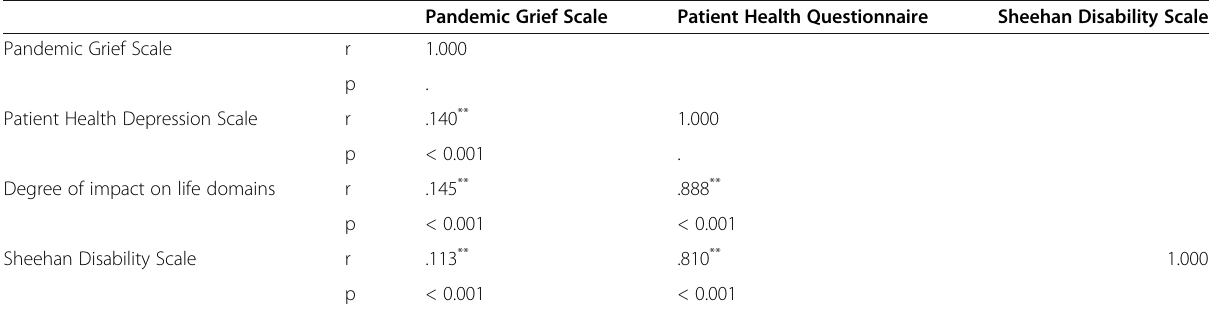
Table 4 Correlation matrix between Pandemic Grief Scale, Patient Health Depression Scale, and Sheehan Disability Scale among studied